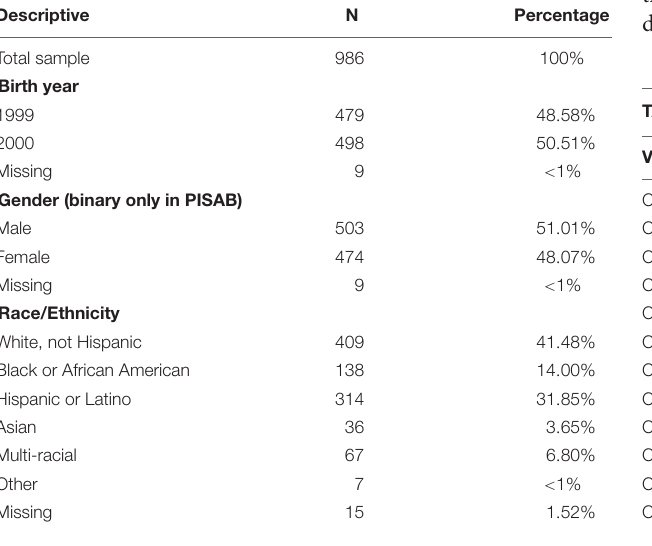
TABLE 1 | Descriptives for collaborative problem solving Xandar assessment for the United States